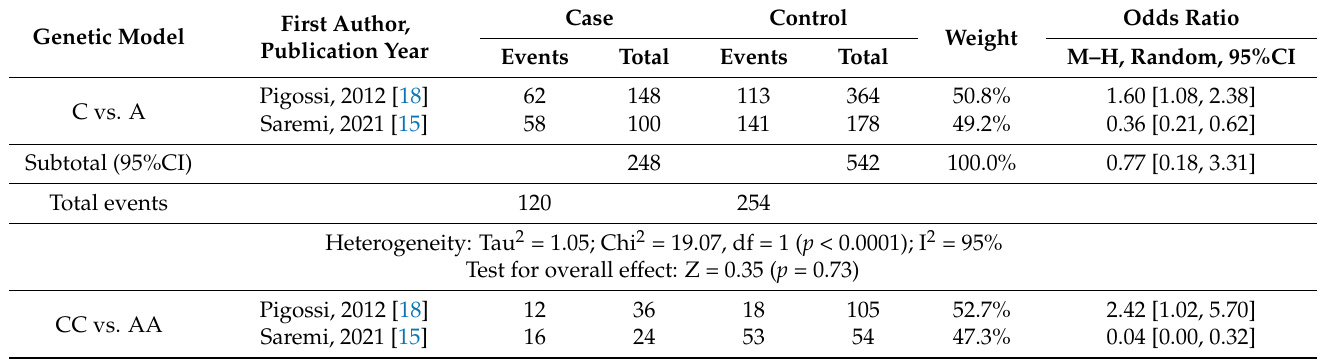
Table 6. Meta-analyses of association between IL-10 ( − 592 A > C) polymorphism and PID risk based on five genetic models. Genetic